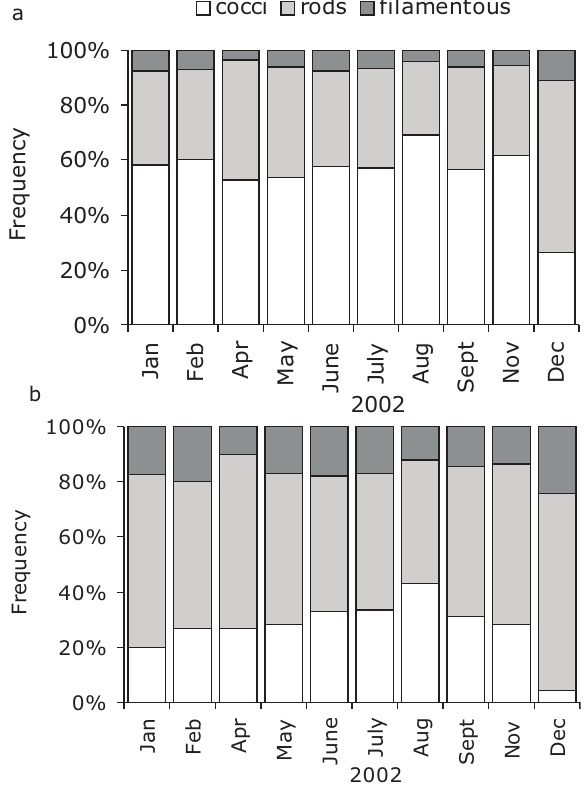
Fig . 6. – relative importance of cocci, rods and filamentous bacteria in total bacterial number (a) and biomass